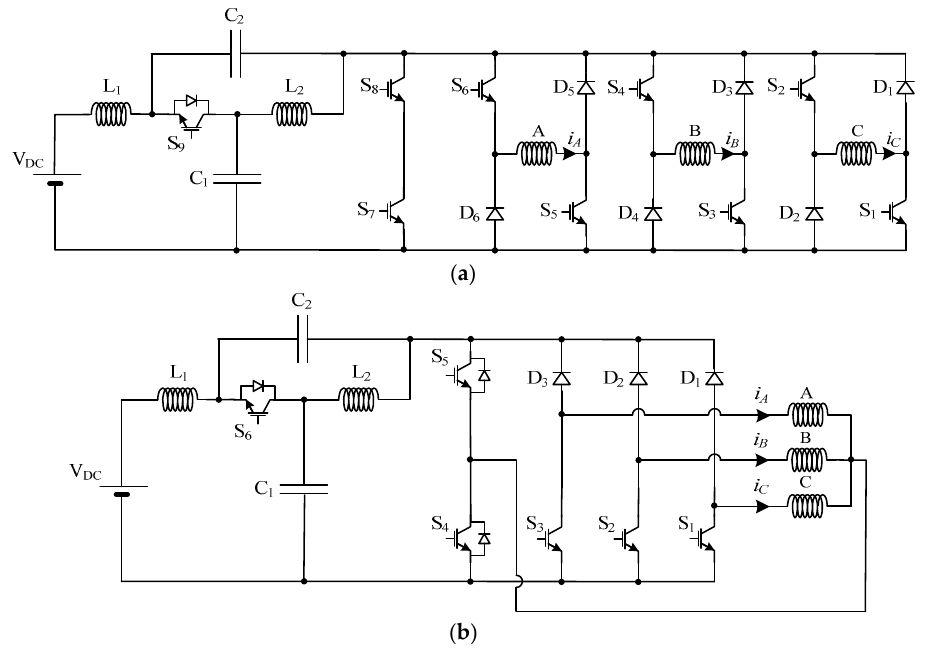
Figure 19. Converters based on the impedance source network ( a ) with extra symmetrical leg ( b ) integration of the symmetrical leg in the legs that control the SRM windings.